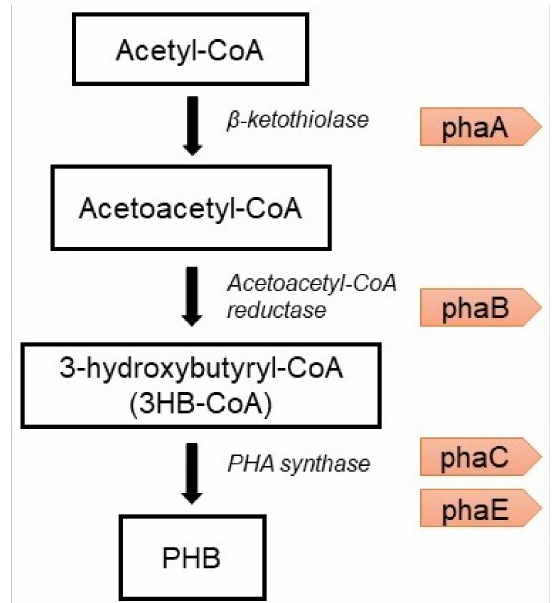
Figure 5. PHB biosynthetic pathway. Table 5. PHB fraction in engineered cyanobacteria under di ff erent cultivation